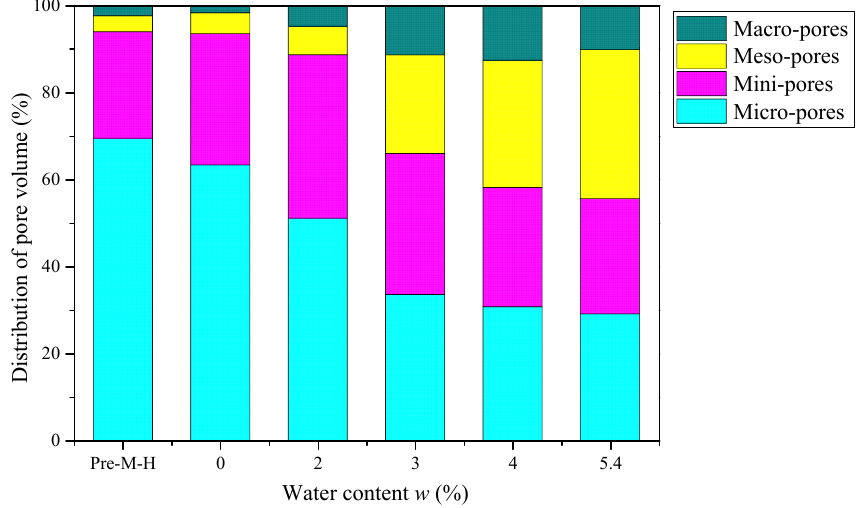
Figure 13. Pore size distribution of sandstone after microwave radiation vs. initial water content.